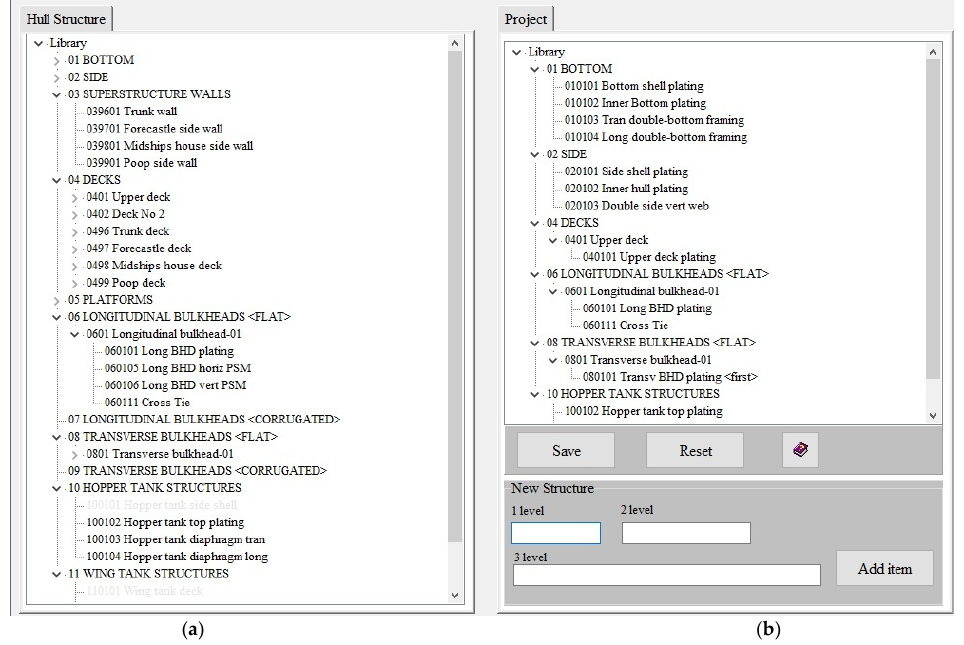
Figure 9. General hierarchical structure directory: ( a ) Directory of top-level structural groups; ( b ) directory of structural groups of second and third levels of the present project.